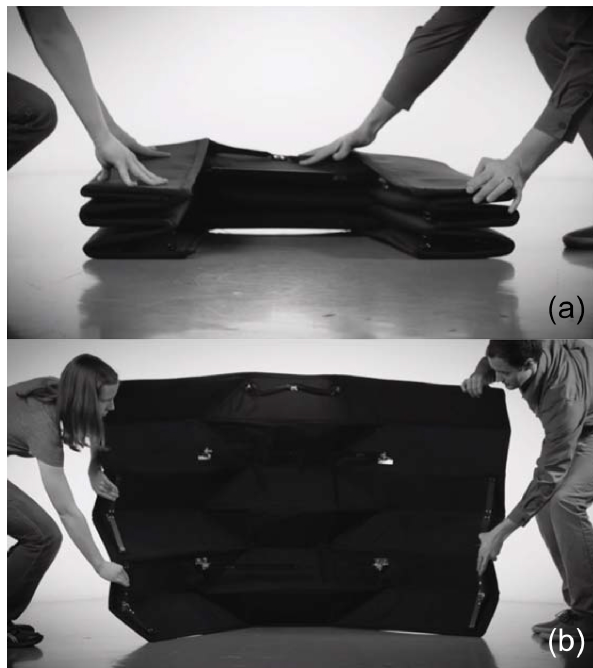
Figure 1. An origami-based ballistic shield in its closed state (a) and deployed state (b) .